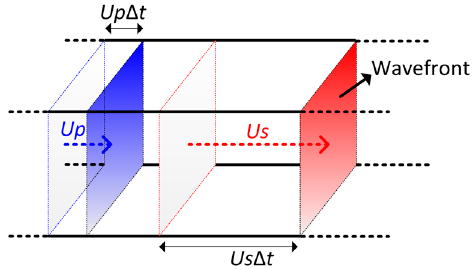
Figure 3. Propagation of a typical shock wave in materials.